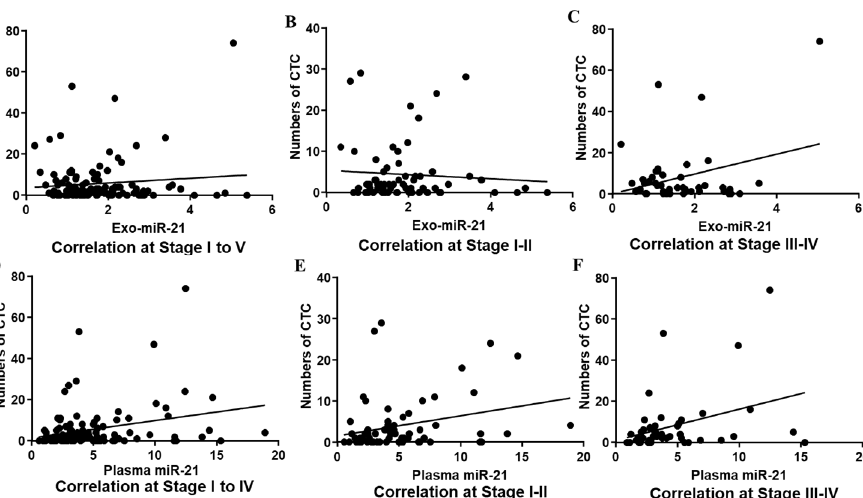
Figure 3. Correlations between plasma/exosomal miR-21 and PB EpCTC numbers in stages. Correla- tions between exosomal miR-21 and numbers of CTC in all stages ( A ), early stage ( B ) and late stage ( C ). Correlations between plasma miR-21 and numbers of CTC in all stages ( D ), early stage ( E ) and late stage ( F ).